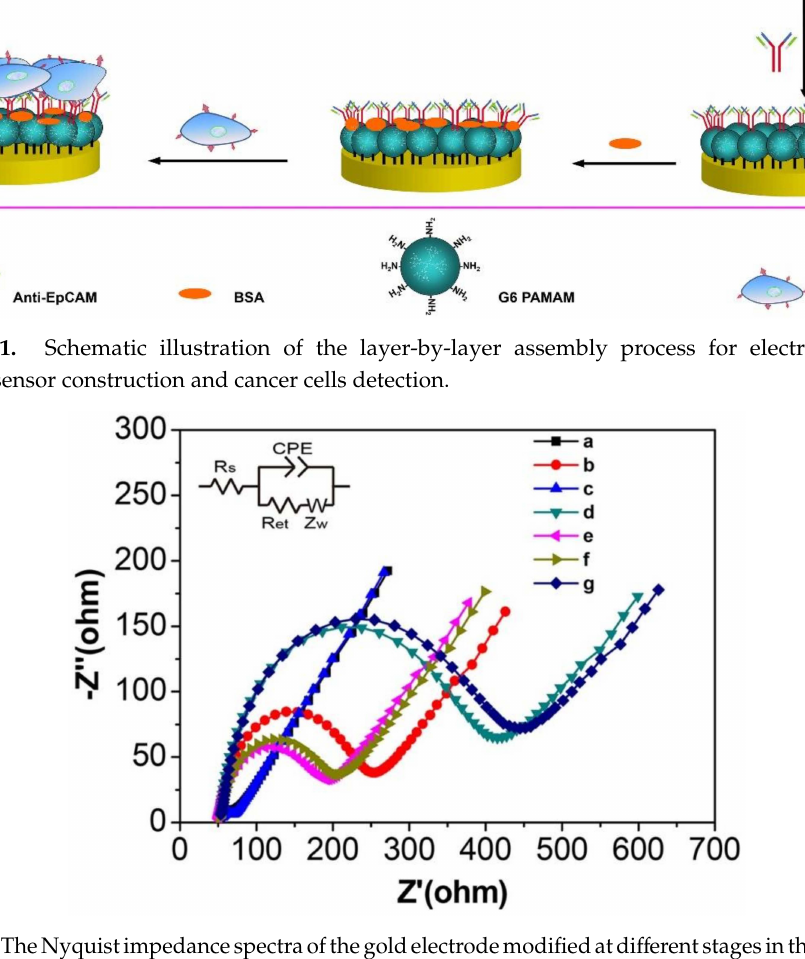
Figure1. TheNyquistimpedancespectraofthegoldelectrodemodifiedatdi ff erentstagesinthepresence of 0.01M pH 7.4 PBS containing 5 mM [Fe(CN) 6 ] 4 − / 3 − and 0.1 M KCl. ( a ) The bare gold electrode; ( b ) MPA / gold electrode; ( c ) G6 PAMAM / MPA / gold electrode; ( d ) G6 PAMAM-COOH / MPA /